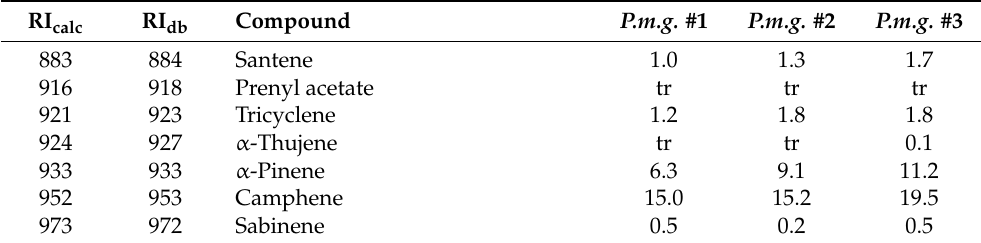
Table 4. Chemical composition (percent) of the leaf essential oils of Pseudotsuga menziesii var. glauca from southern Idaho.